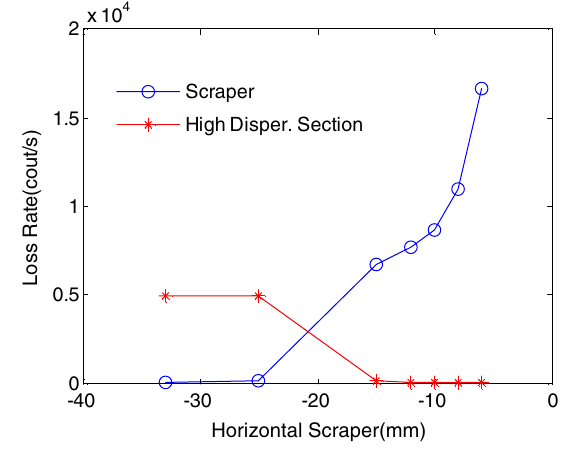
FIG. 1 (color online). Loss rates at the high dispersion section and the scraper for different horizontal scraper locations.